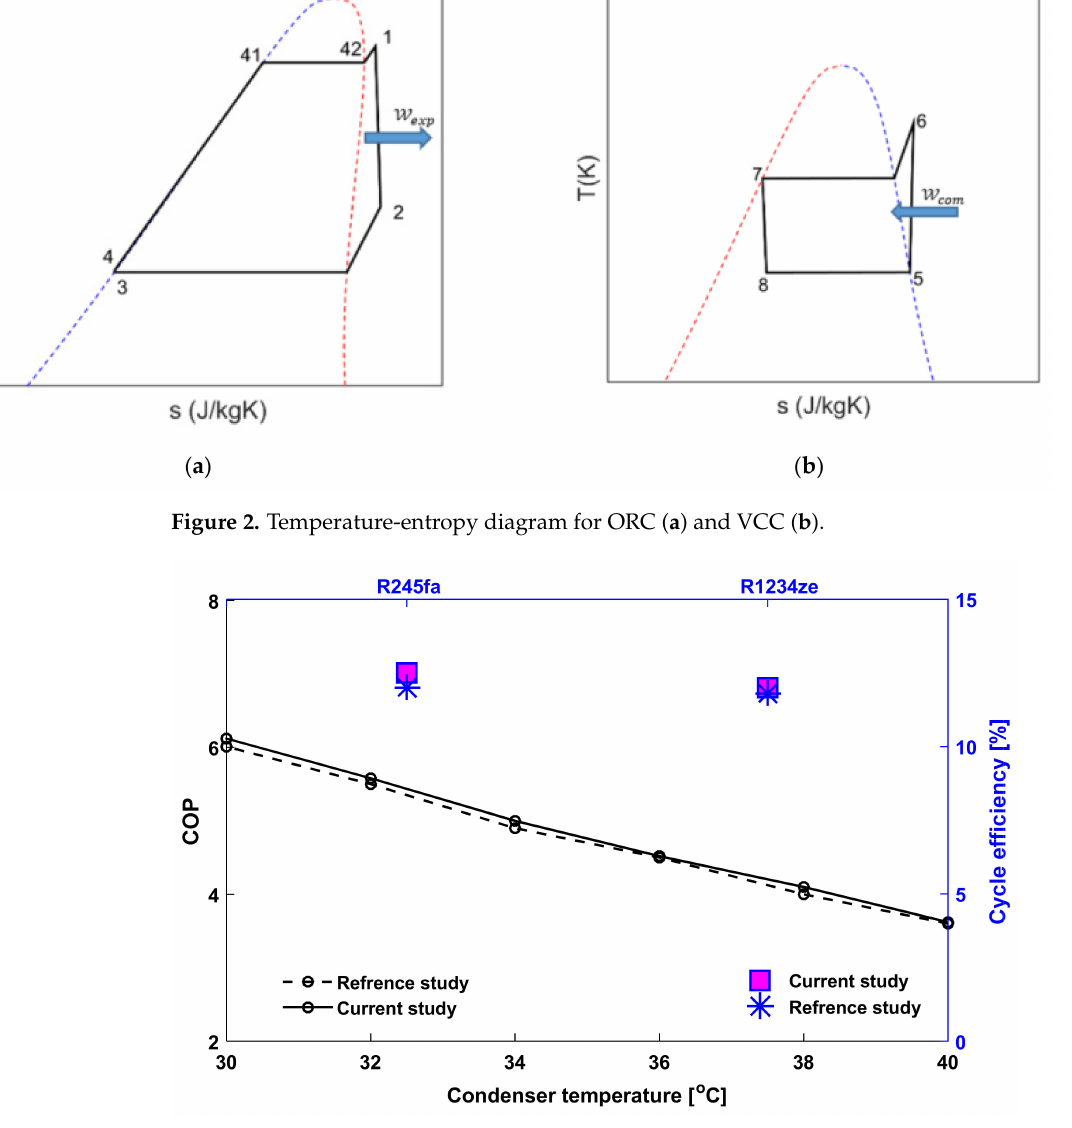
Figure 3. Validation of calculation methodology for each